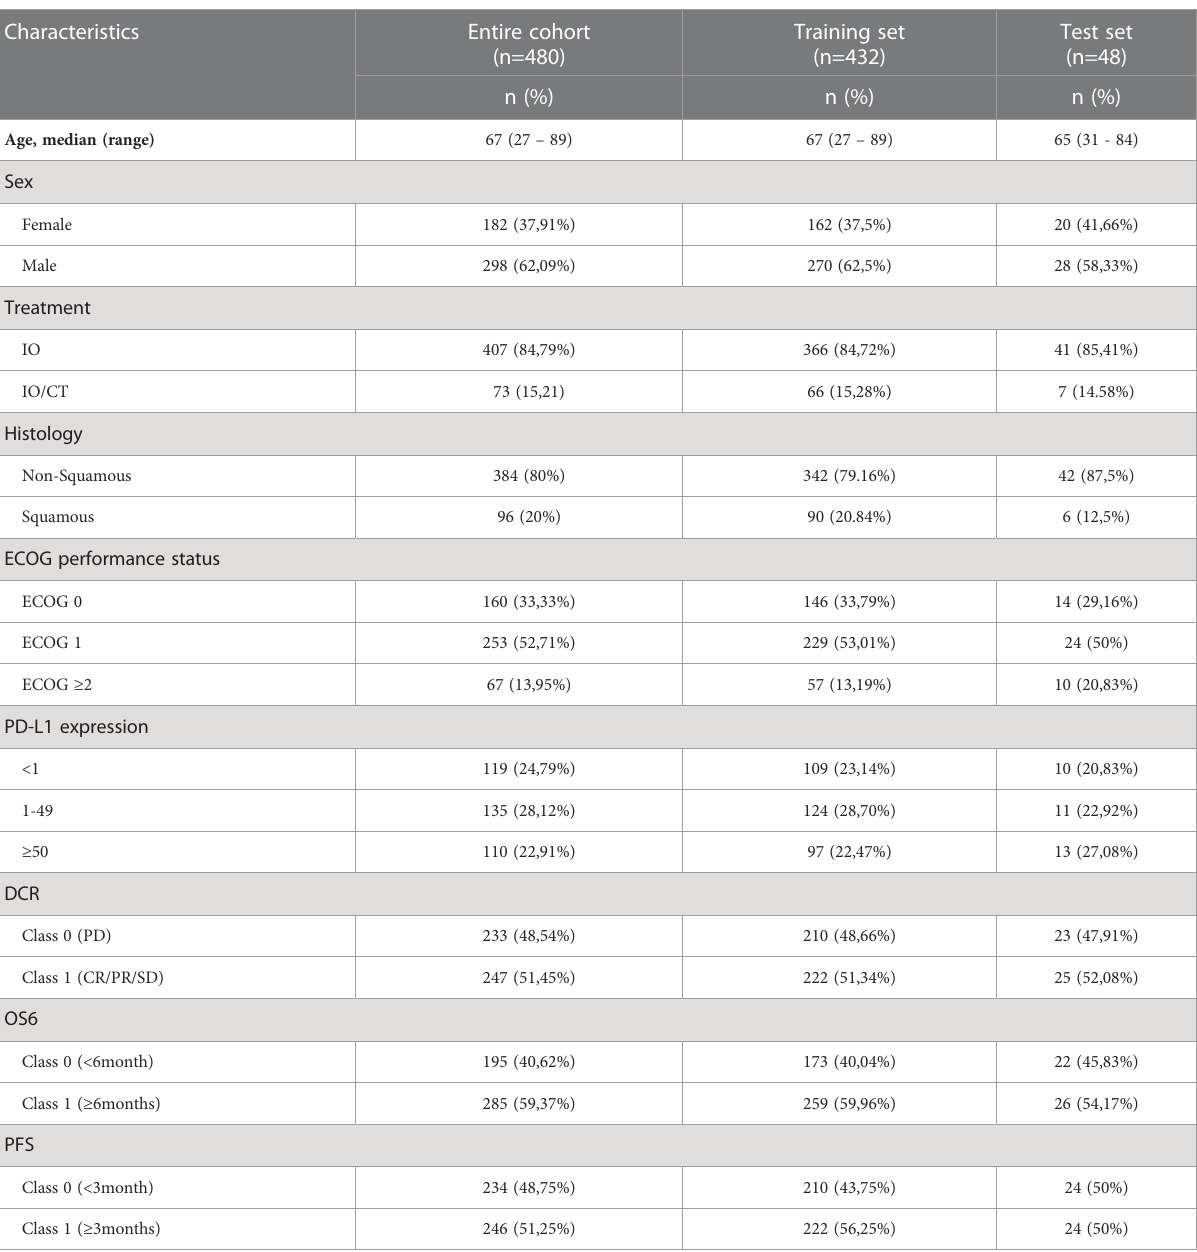
TABLE 2 Patient characteristics used in this